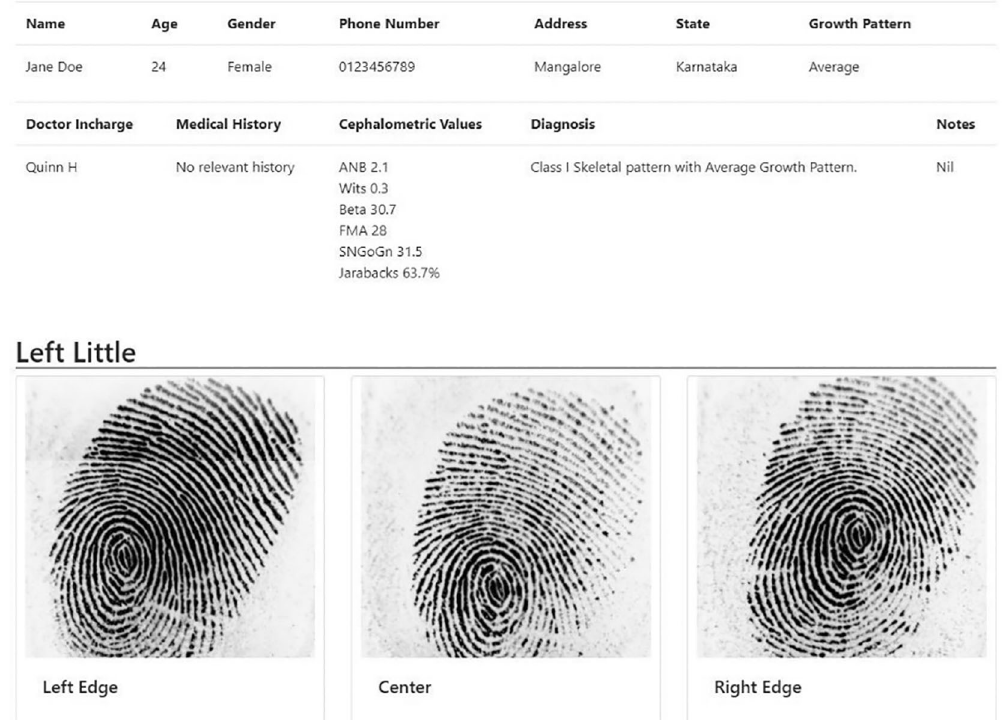
Figure 2. Data of a sample patient as seen in the ‘ Fingerprince ’ application after collection of